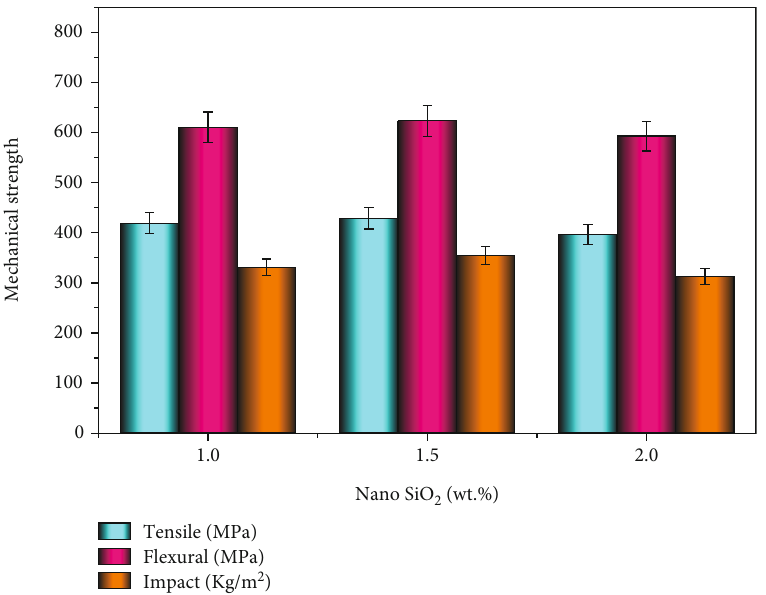
Figure 4: Mechanical properties of nanocomposites based on the weight ratio of nanosilica.